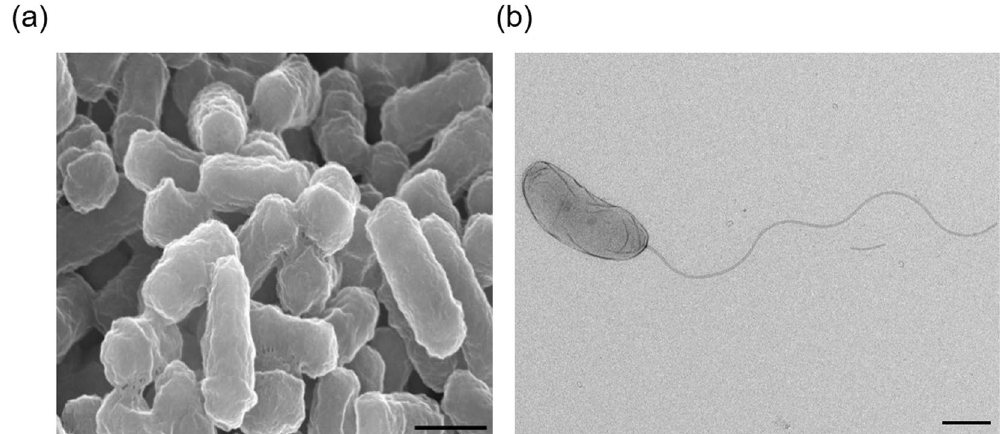
Figure 2. The cell morphology of strain AS8 as determined by scanning ( a ) and transmission ( b ) electron microscopy. Scale, 0.5 μ